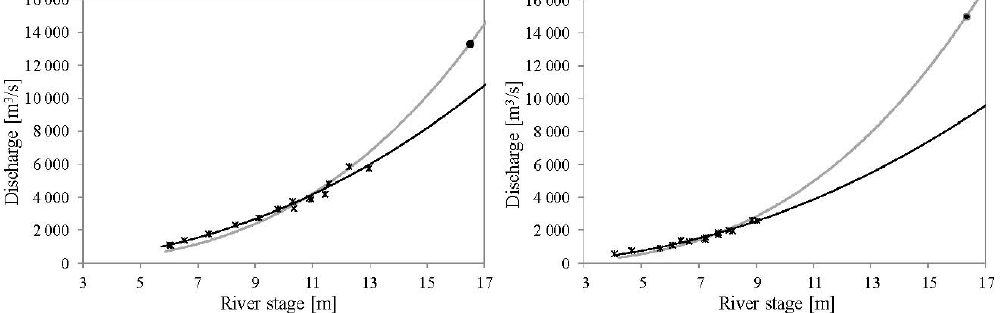
Fig. 4. Cremona cross-section: examples of synthetic measurement campaigns (stars); estimated maximum discharge capacity at Cremona cross-section ( h max − Q max , black point); Traditional (black line) and Constrained (grey line) rating-curves.